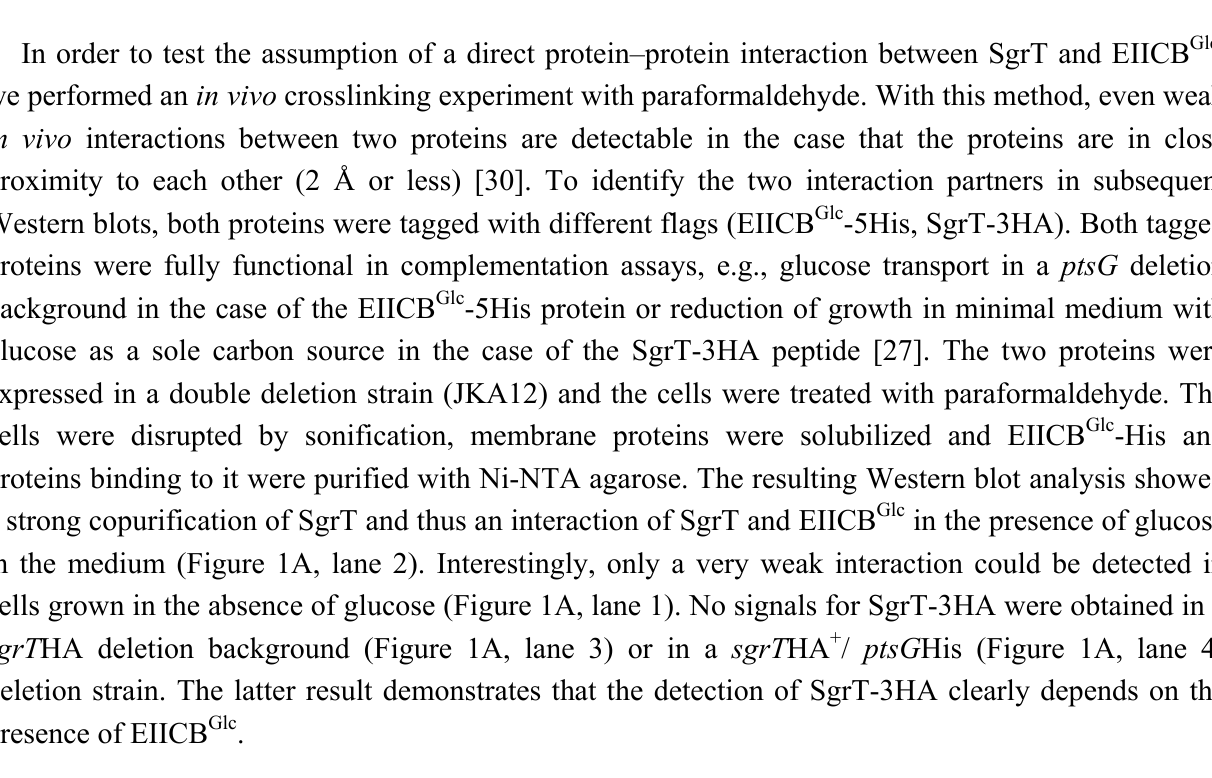
Figure 1. Crosslinking experiments with EIICB Glc and SgrT in different genetic